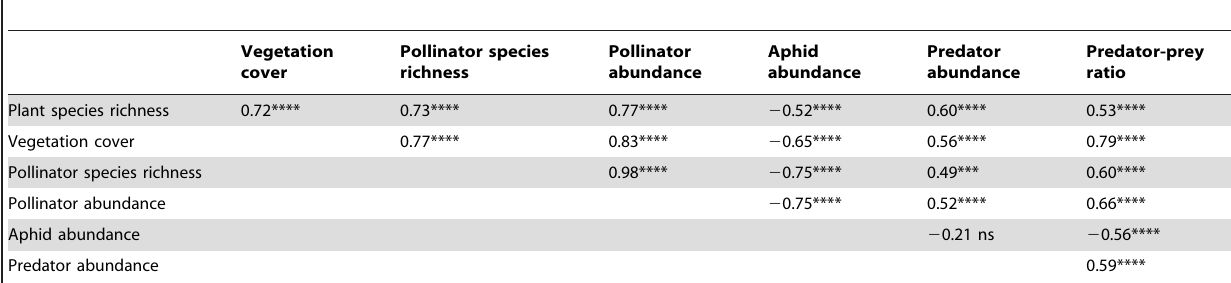
Table 2. Pearson correlations (r-values) between response variables of the 60 study locations in 30